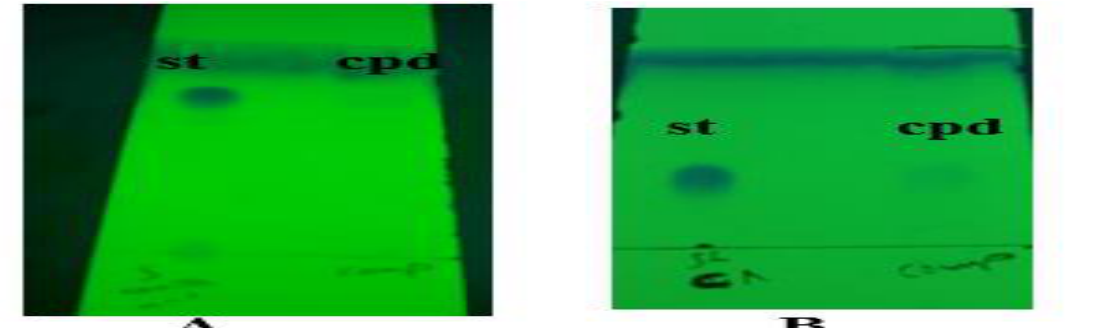
Figure 3. TLC chromatogram for isolated cpd A: E1 and standard vanillic acid B: C4 and standard coumaric acid developed in the (chloroform acetone: formic acid) (75:16:1) solvent system, Detect under UV light at 254.